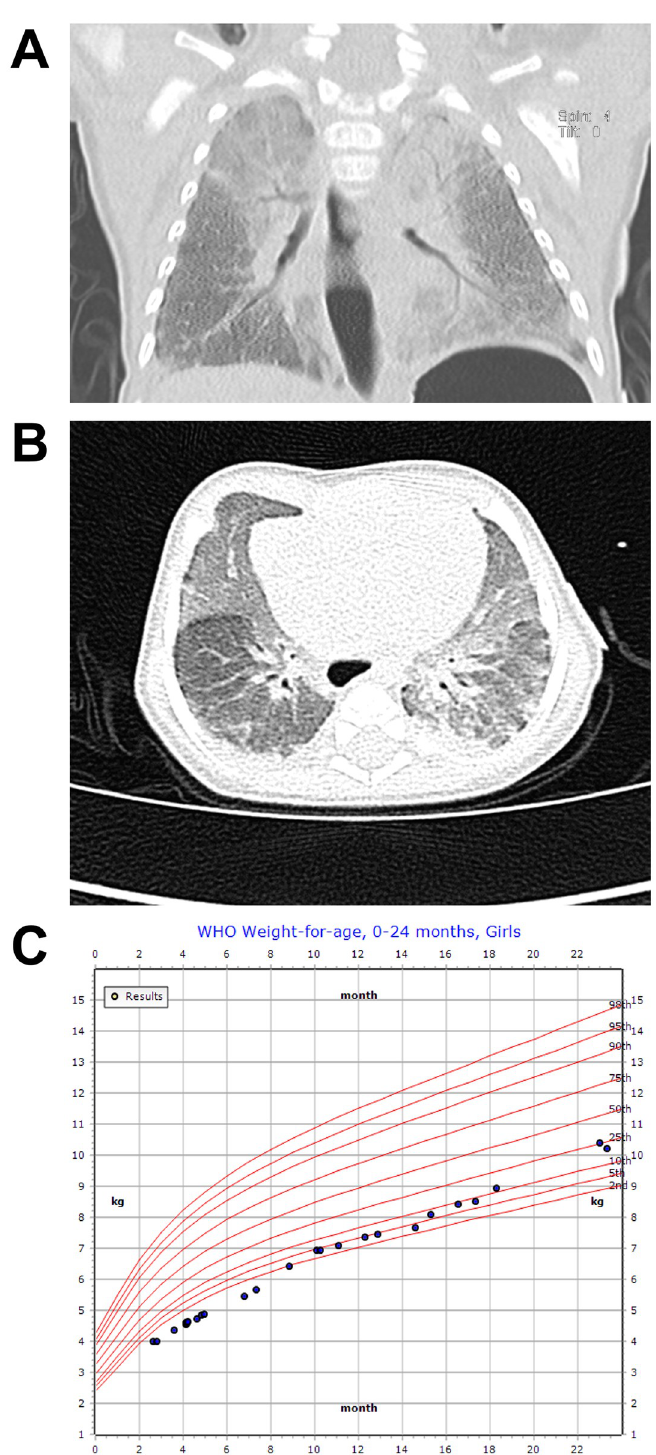
Fig 1. Clinical findings of the proband with homozygous ARHGAP42 stop-gain variant. (A) Chest X-ray at age 3 months showed bilateral diffuse opacities and low lung volumes; (B) Initial chest CT scan at age 3 months displayed diffuse ground glass opacities with subpleural sparing and patchy subpleural opacities; (C) Patient growth chart for weight through two years of age.